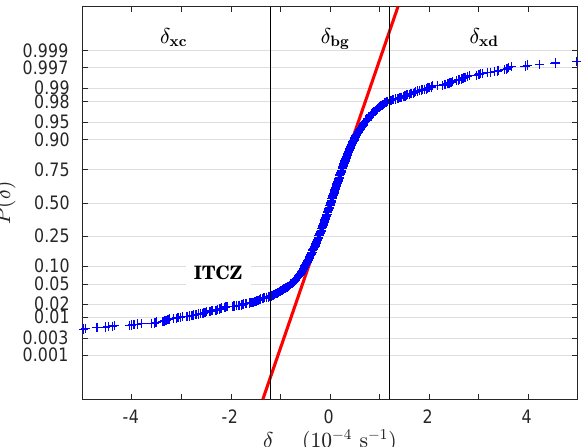
Figure 7. Normal probability plot of ITCZ PDF. PDF follows a Gaussian distribution where it falls on or close to red line. Vertical lines ( ± 2 σ All ) partition δ into extremes ( δ xc and δ xd ) and background ( δ bg ). Note that figure does not show full range of δ values. Left and right tails extend much further out (to about ± 14 × 10 − 4 s − 1 )—see Figure 6. Table 2. Wind divergence classes and thresholds. Thresholds, ± 2 σ All , map δ to